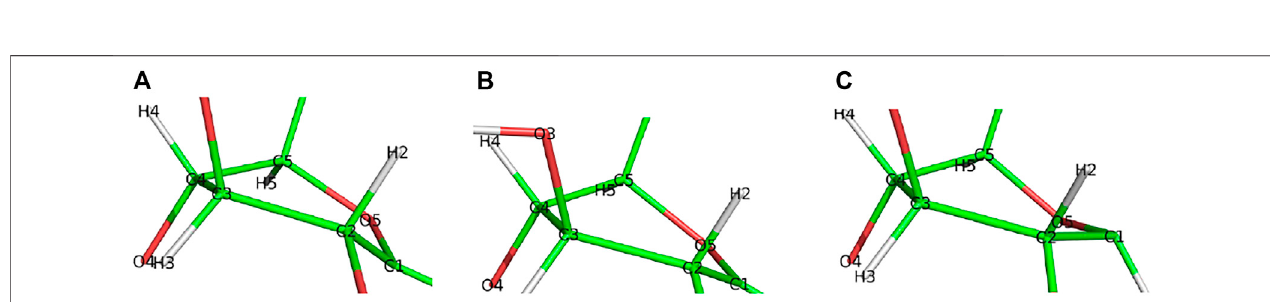
FIGURE 9 | Conformational change of the glycosyl unit Glc − 1 in the deglycosylation reaction from (A) 4 C 1 in R2 to (B) 4 H 3 in TS2 to (C) 4 E in P2.